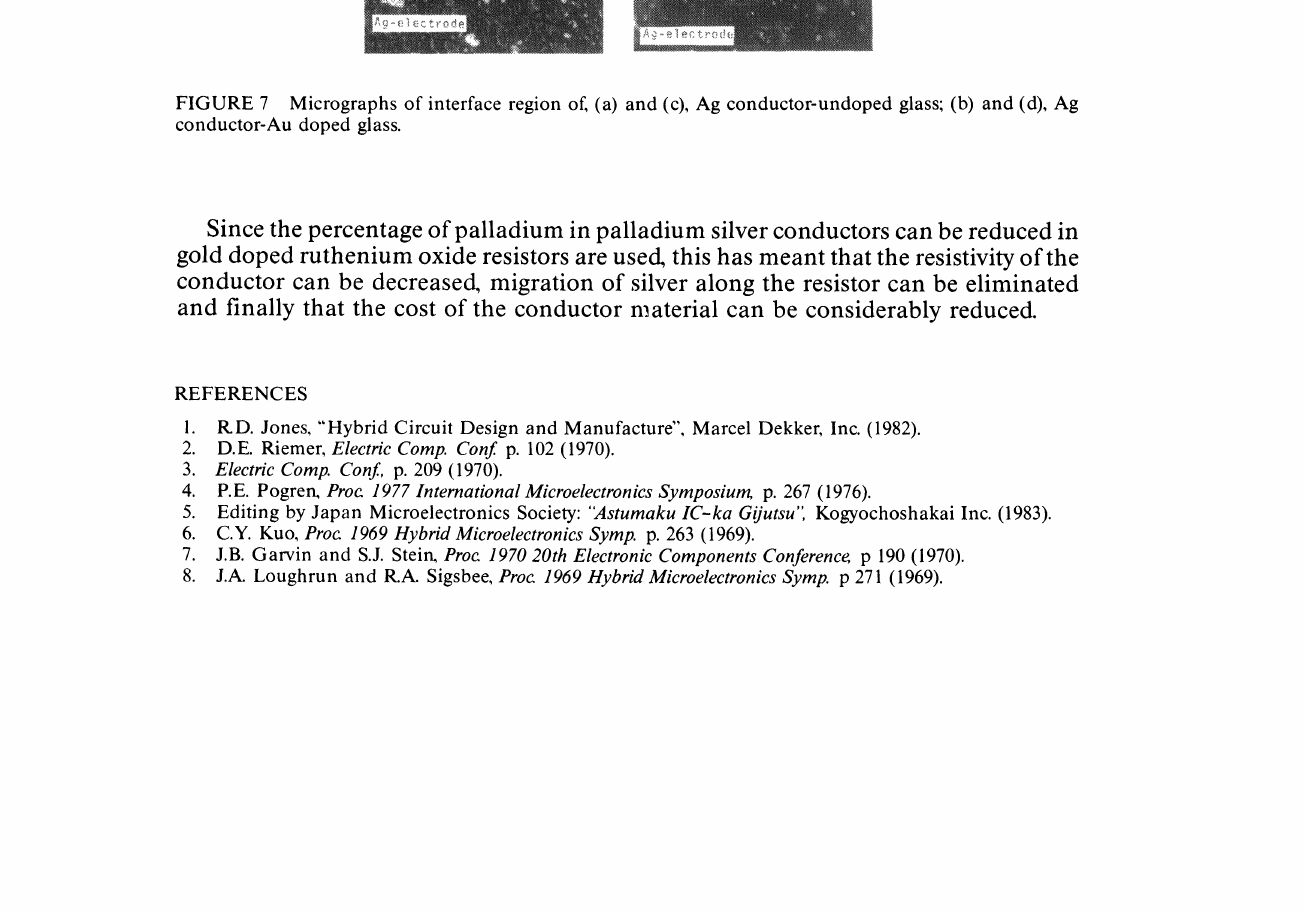
FIGURE 7 Micrographs of interface region of, (a) and (c), Ag conductor-undoped glass; (b) and (d), Ag conductor-Au doped